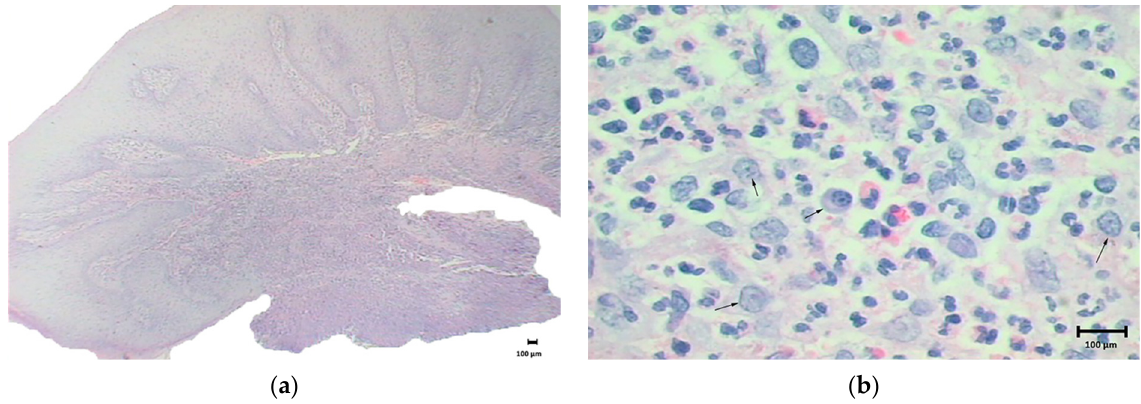
Figure 3. Histological analysis of the lesion. ( a ) Histological image showing inflammatory process, magnification: 10×, staining: hematoxylin and eosin; ( b ) Histological image showing polymorphonuclear cells (black arrows), magnification 100×, staining: hematoxylin and eosin.